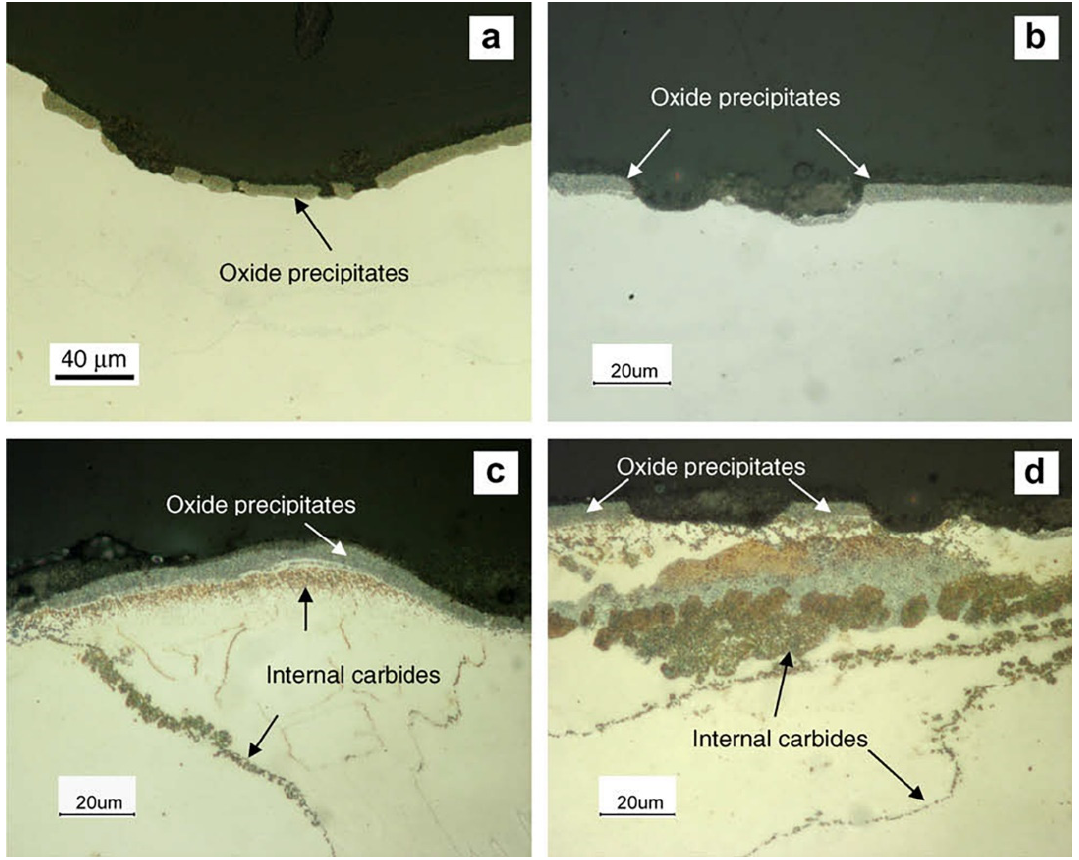
Figure 19. ( a , b ) Polished and ( c , d ) Murakami etched cross-sections of 304 austenitic steel after 141 cycles of reaction in CO/H 2 /H 2 O gas at 680 °C/1 bar [109]. Reproduced with permission from Elsevier.